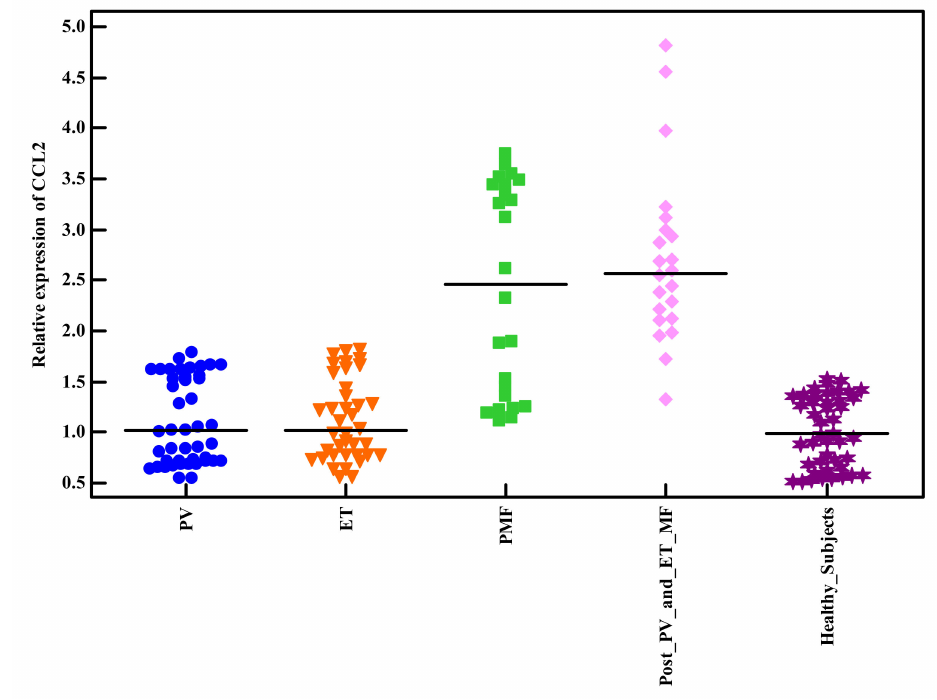
Figure 1. Relative expression of CCL2 among Philadelphia-negative MPNs patients and healthy subjects. Table 4. Genotype–phenotype correlations in Philadelphia-negative MPNs patients ( n =